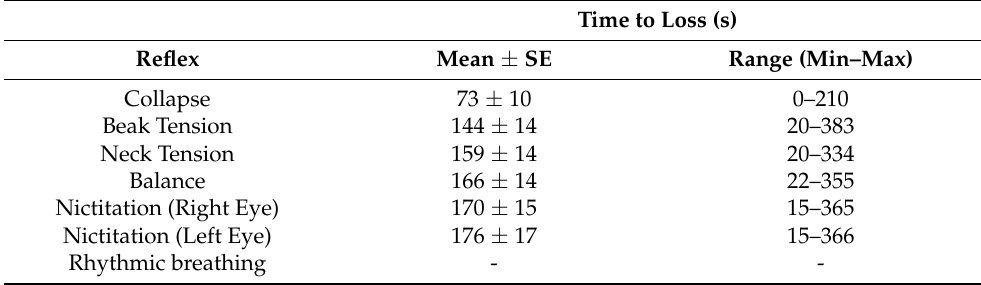
Table 2. Time to loss of behaviors and brainstem reflexes ( n = 34) following the neck cut, all values include the 15 s it took from the neck cut to the beginning of assessment.